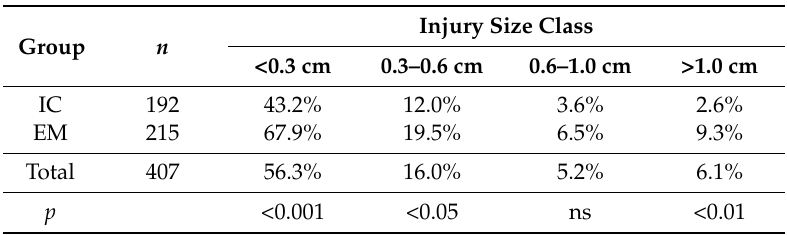
Table 3. Size distribution of injuries in % of animals of IC and EM and significance of difference between IC and EM (chi-square